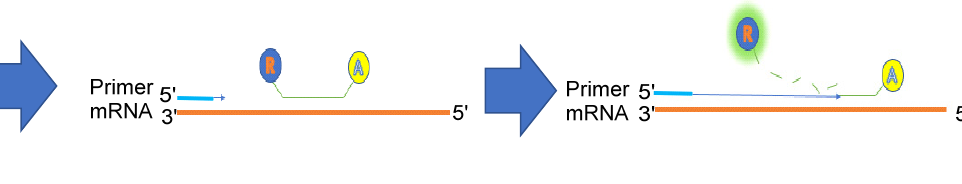
Figure 11. Schematic illustration of oligonucleotide hydrolysis probe when it was used for visualiz- ing